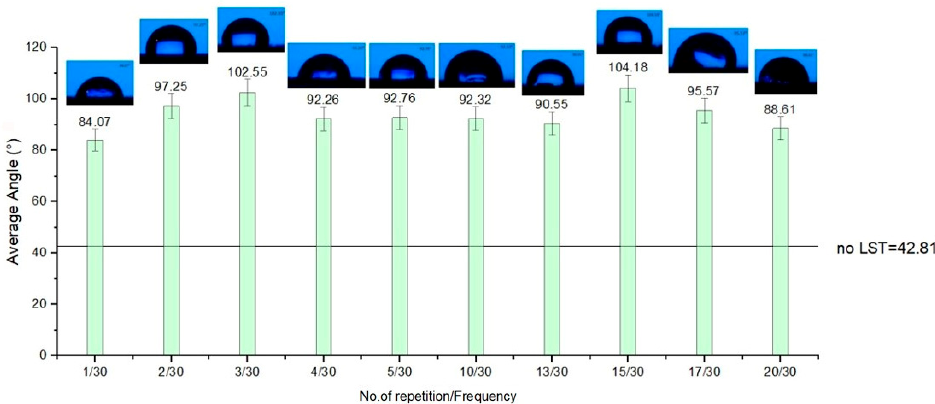
Figure 11. Average contact angle for design type A.